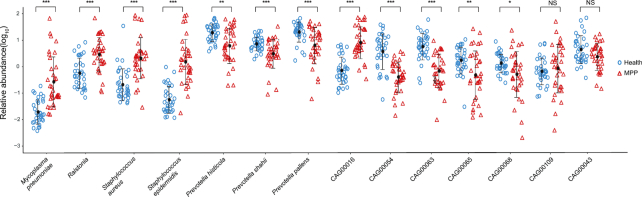
Comparison of relative abundance of 14 re-assembled genomes between healthy children and children with Mycoplasma pneumoniae pneumonia. Blue circles and red triangles represent the microbial relative abundance of healthy children and children with Mycoplasma pneumoniae pneumonia (MPP). Solid dot and paired whiskers represent the mean and SD of each microbial relative abundance. P-values at *, ≤0.05; **, ≤0.01; and ***, ≤0.001, respectively. NS, not significant.